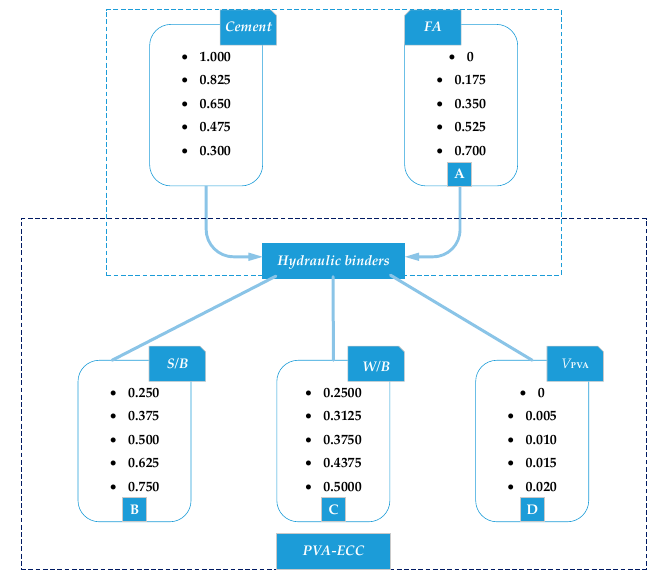
Figure 3. The schematic diagram of varying levels for mix design factors. Table 3. The mix formulations for engineered cementitious composites (ECC) using L 25 orthogonal array.